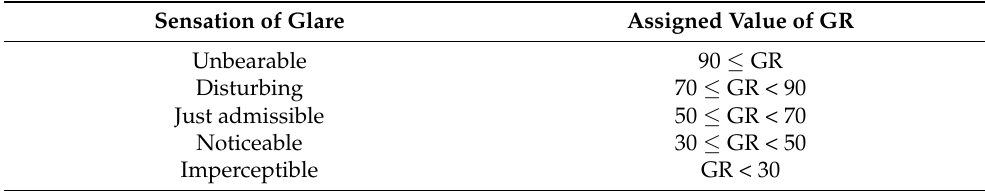
Table 3. Proposed assignment of GR values to the scale of the subjective sensation of